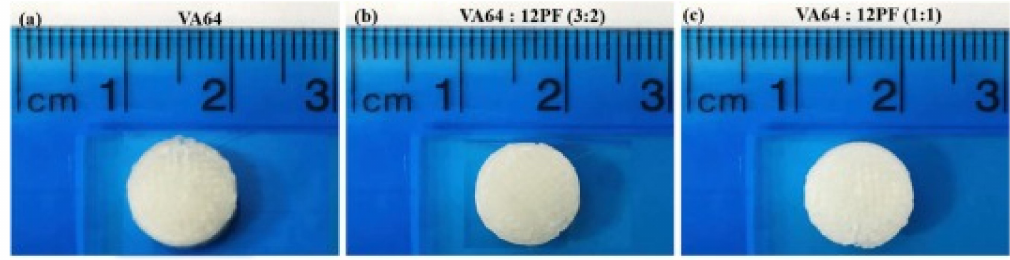
Figure 10. Pictures of ramipril printlets. ( a ) VA64, ( b ) VA64:12PF (3:2) and ( c ) VA64:PF12 (1:1). Image reproduced with permission from [78]. Copyright Elsevier,